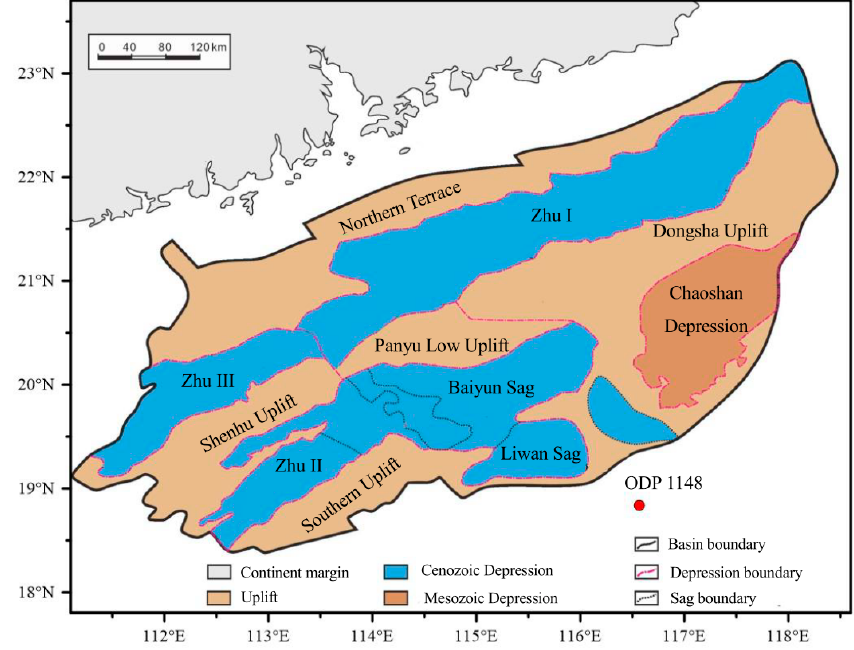
Figure 2. Geological map showing the Pearl River Mouth Basin (PRMB).